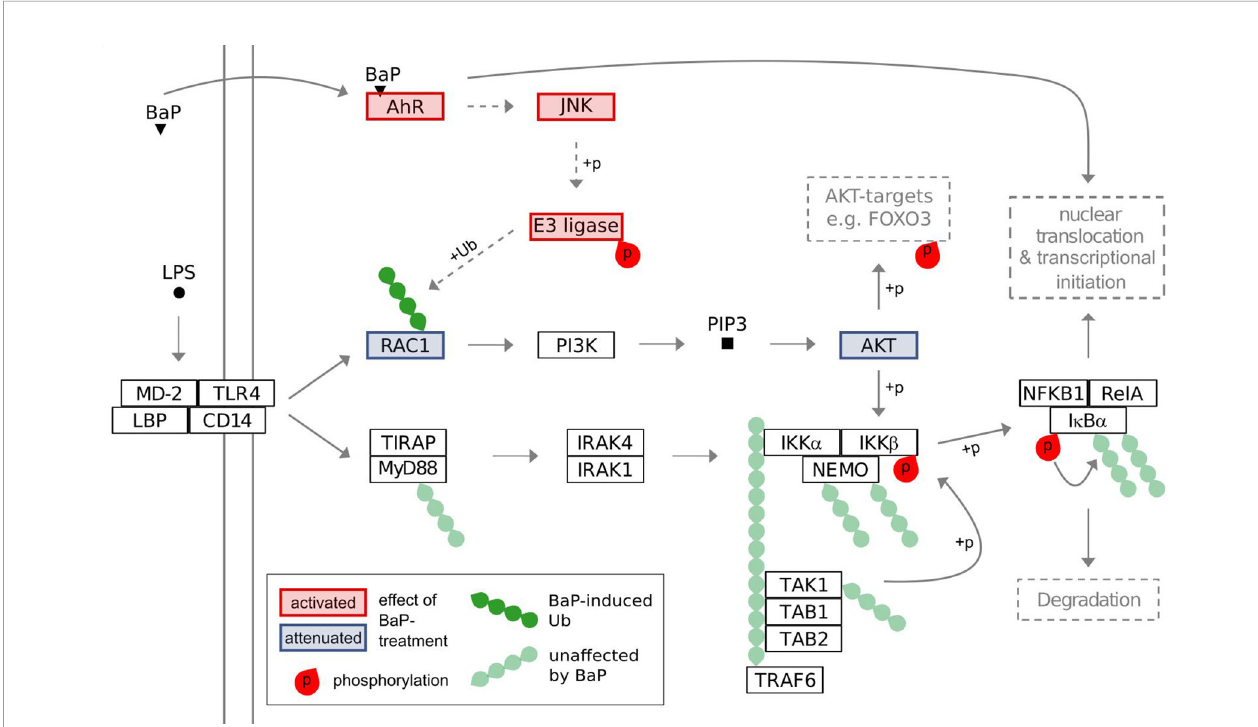
FIGURE 7 | Suggested model of interference of BaP-activated AhR with TLR4 signaling. The model is based on the results of the conducted multi-PTM-omics study and the KEGG-pathways for Toll-like receptor signaling and PI3K-Akt